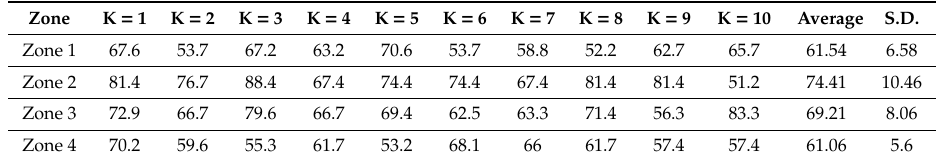
Table 8. The 10-fold cross-validation results (%). (SD: standard deviation.).